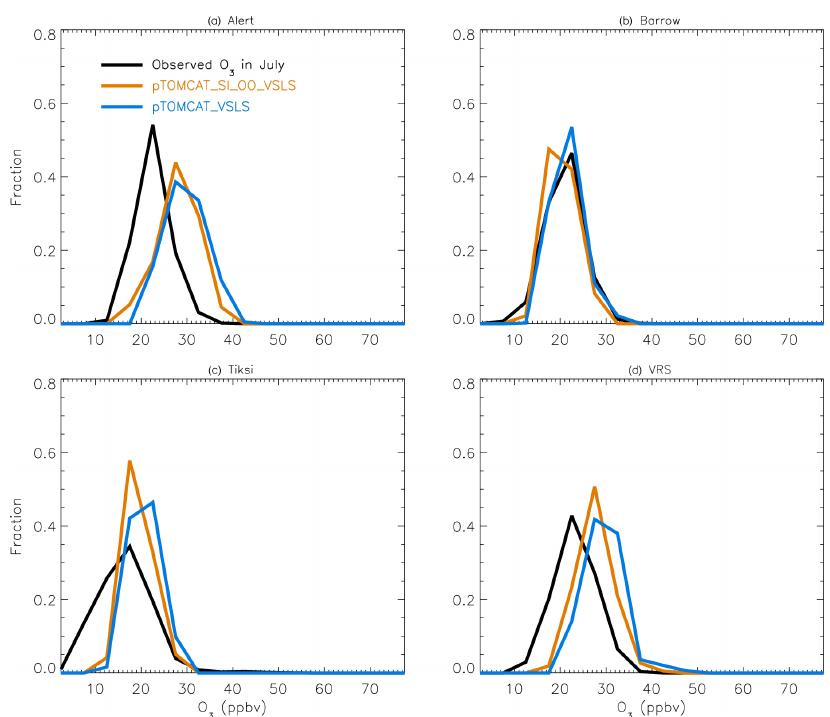
Figure 4. July surface ozone fractional distribution (with a bin interval of 5ppbv). The observed fractional distribution is shown by the black line, with the pTOMCAT_control result shown in solid orange and pTOMCAT_VSLS shown in solid blue.